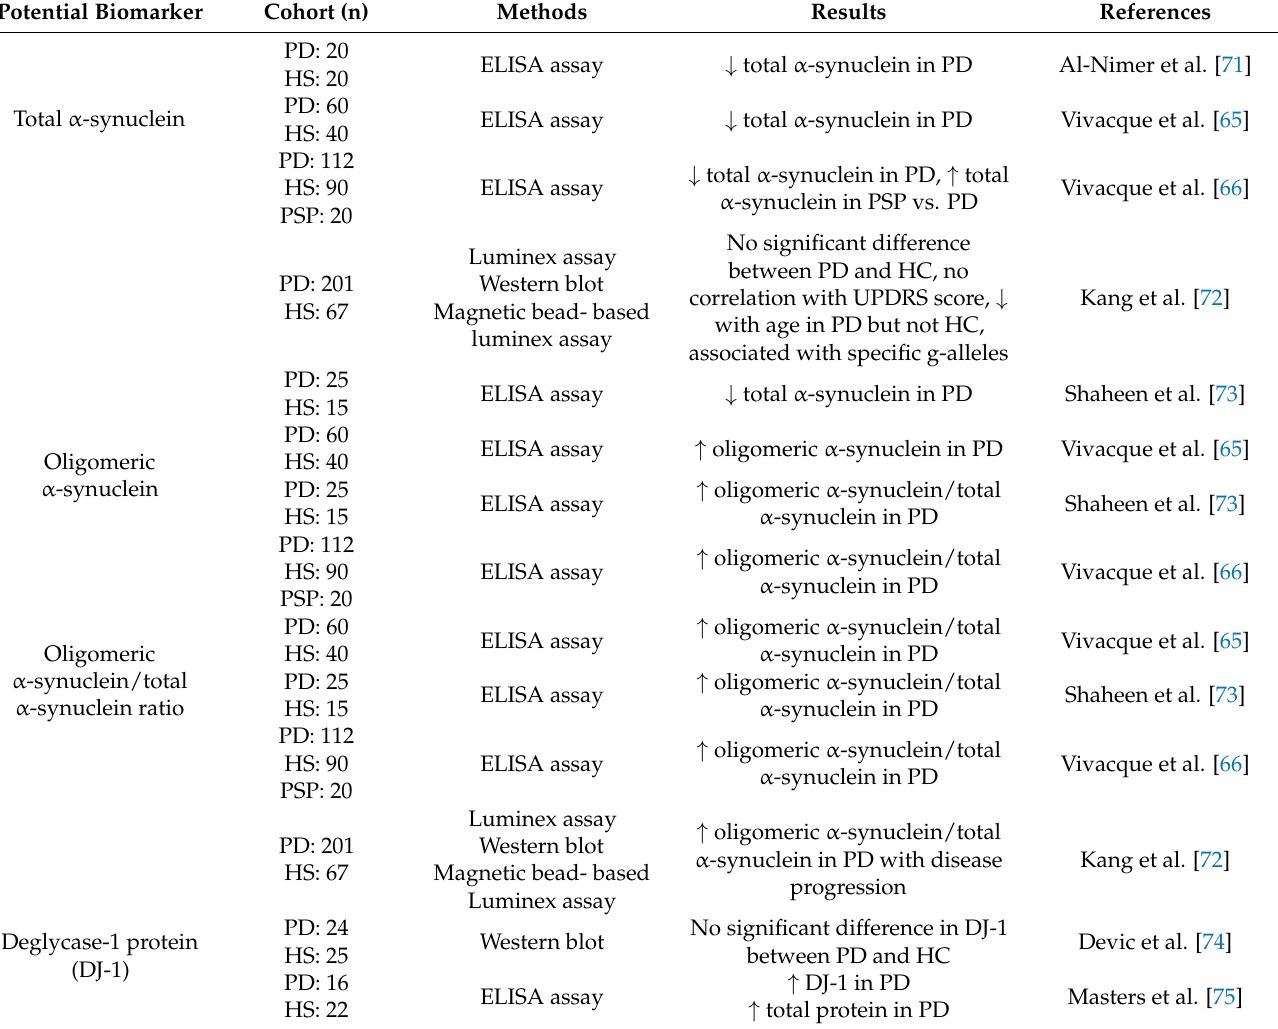
Table 4. Potential salivary biomarkers associated with Parkinson’s disease (PD) described in studies. Potential Biomarker Cohort (n) Methods